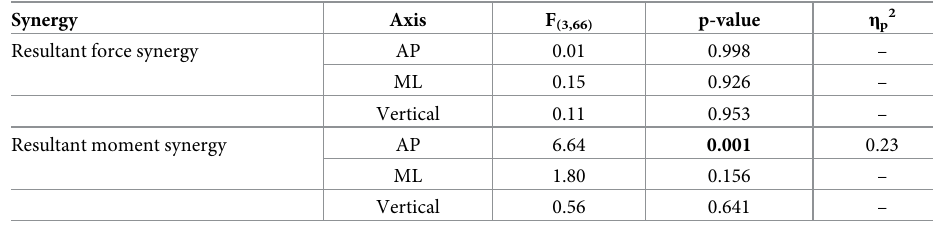
Significant effects of Task are bolded.